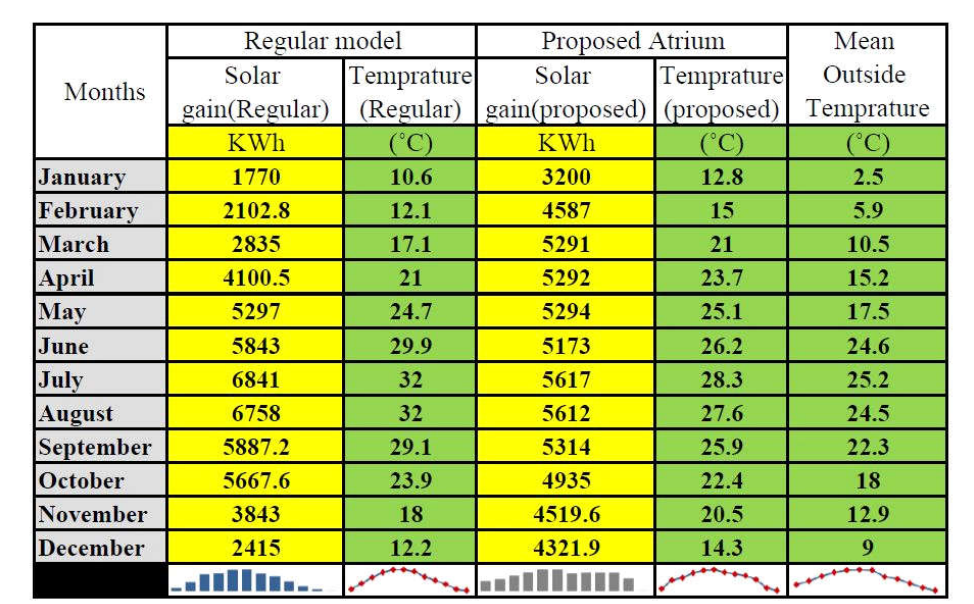
Fig.6: Comparison of temperature and solar gain between different